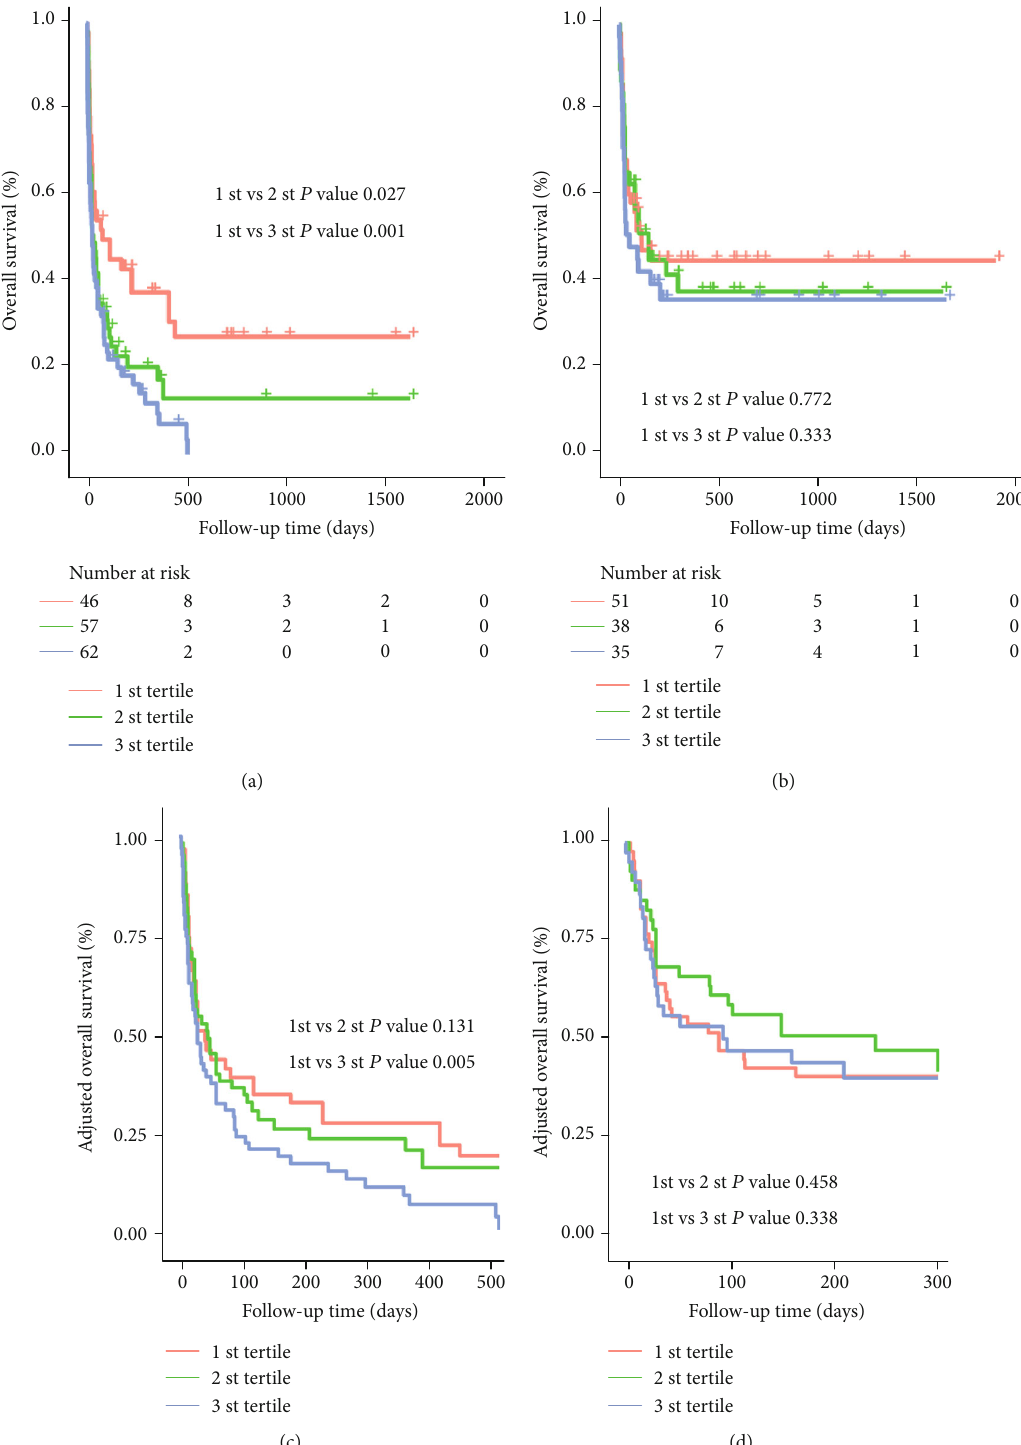
Figure 6: Survival curves in patients with HLH according to De Ritis ratio tertiles. (a, b) Kaplan-Meier survival curves in MHLH and non- MHLH. (c, d) Adjusted survival curves in MHLH and non-MHLH: curves are adjusted for hepatomegaly, albumin (ALB), fi brinogen (FIB), EBV, ferritin, malignancy-associated HLH (MHLH), and treatment